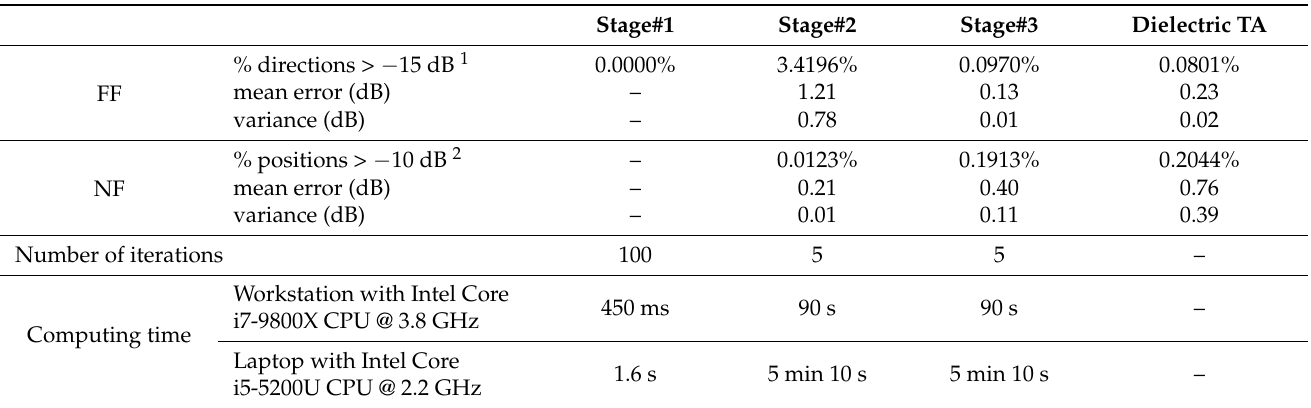
Table 2. Case 2: Summary of synthesis results: errors and computing